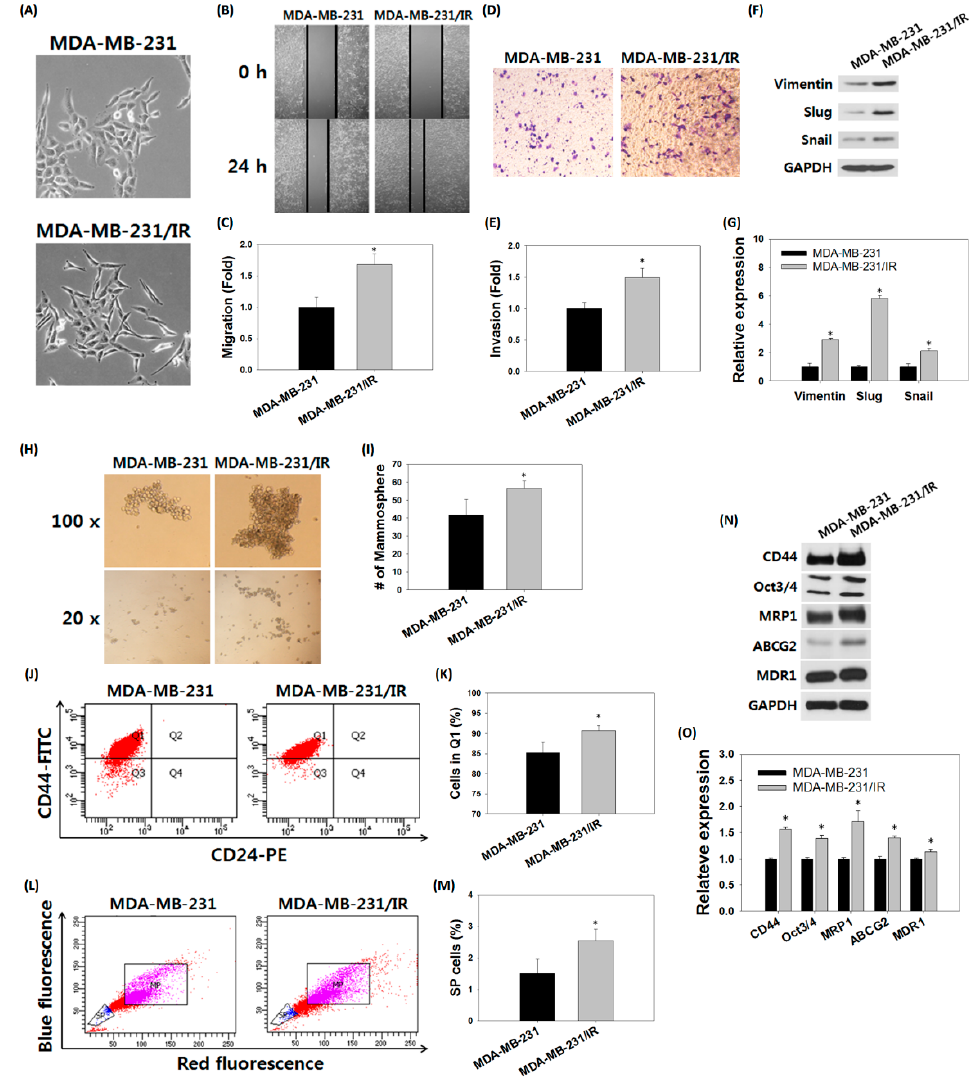
Figure 2. Stem cell-like characteristics of MDA-MB-231/IR cells. ( A ) Morphologies of MDA-MB-231 cells and MDA-MB-231/IR cells. ( B , C ) Migration and ( D , E ) invasion were analyzed on same number of MDA-MB-231 cells and MDA-MB-231/IR cells for 24 h. ( F , G ) Western blot assay for detection of EMT markers expressed in MDA-MB-231 cells and MDA-MB-231/IR cells. GAPDH was used as a control; band intensities were quantified using ImageJ. ( H , I ) Mammosphere formation over seven days, ( J , K ) expression of cell surface markers, and ( L , M ) side population (SP) were detected by FACS analyses. ( N , O ) Western blot assay for stem cell markers on MDA-MB-231 cells and MDA-MB-231/IR cells. Asterisks (*) indicate significant differences at p < 0.05.